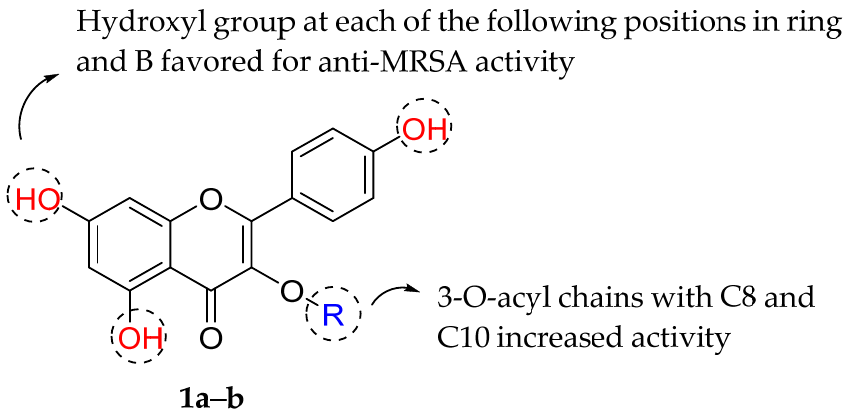
Figure 3. SAR analysis of tested flavonoids [70].